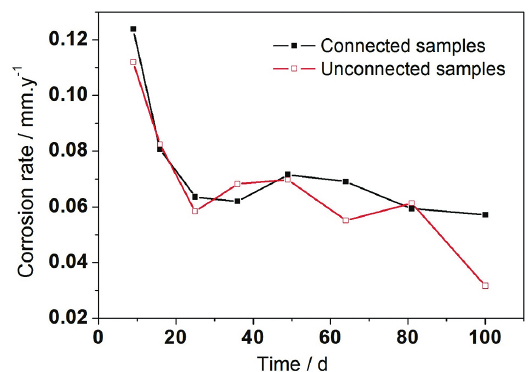
Figure 4. Corrosion rate during exposure time of buried samples related to the geometric surface area.